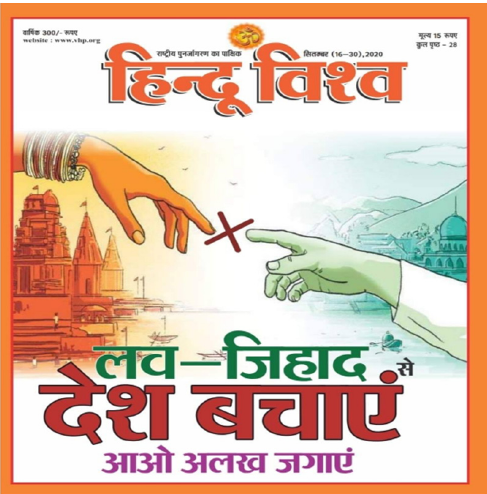
Figure 12. VHP’s magazine Hindu Vishwa’s September edition titled ‘Save the country from Love Jihad, Let’s create awareness’.